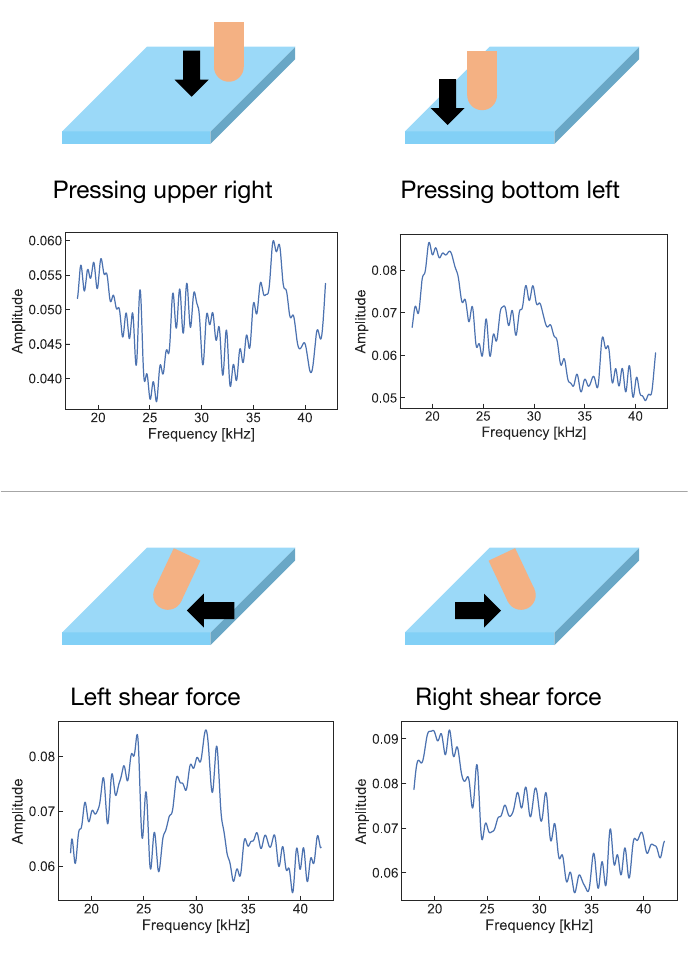
Figure 2. Change in frequency